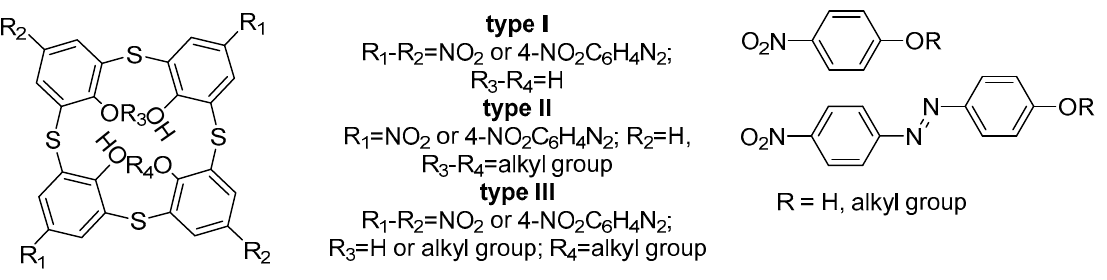
Figure 2. Design of nitrothiacalix[4]arenes and monomer nitrophenols.